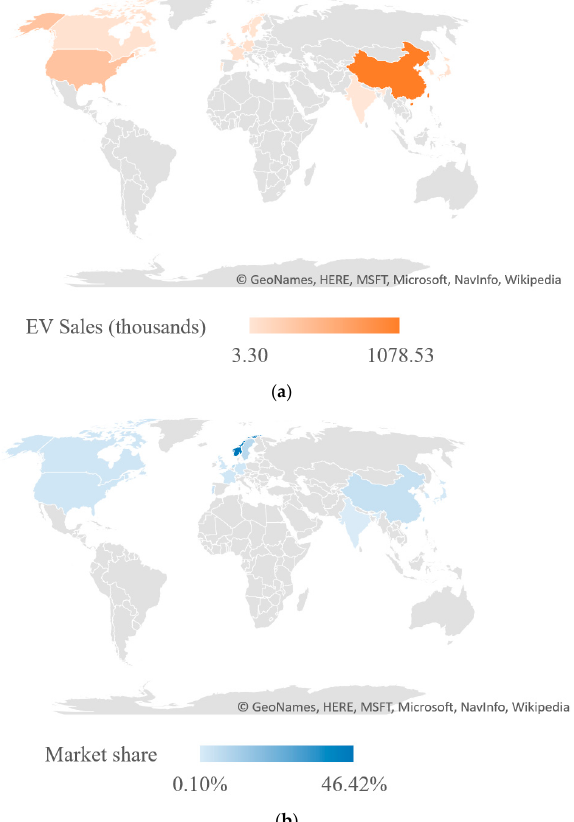
Figure 1. EV sales and market share worldwide overview. ( a ) EV sales in 2018; ( b ) market share of EVs in 2018.